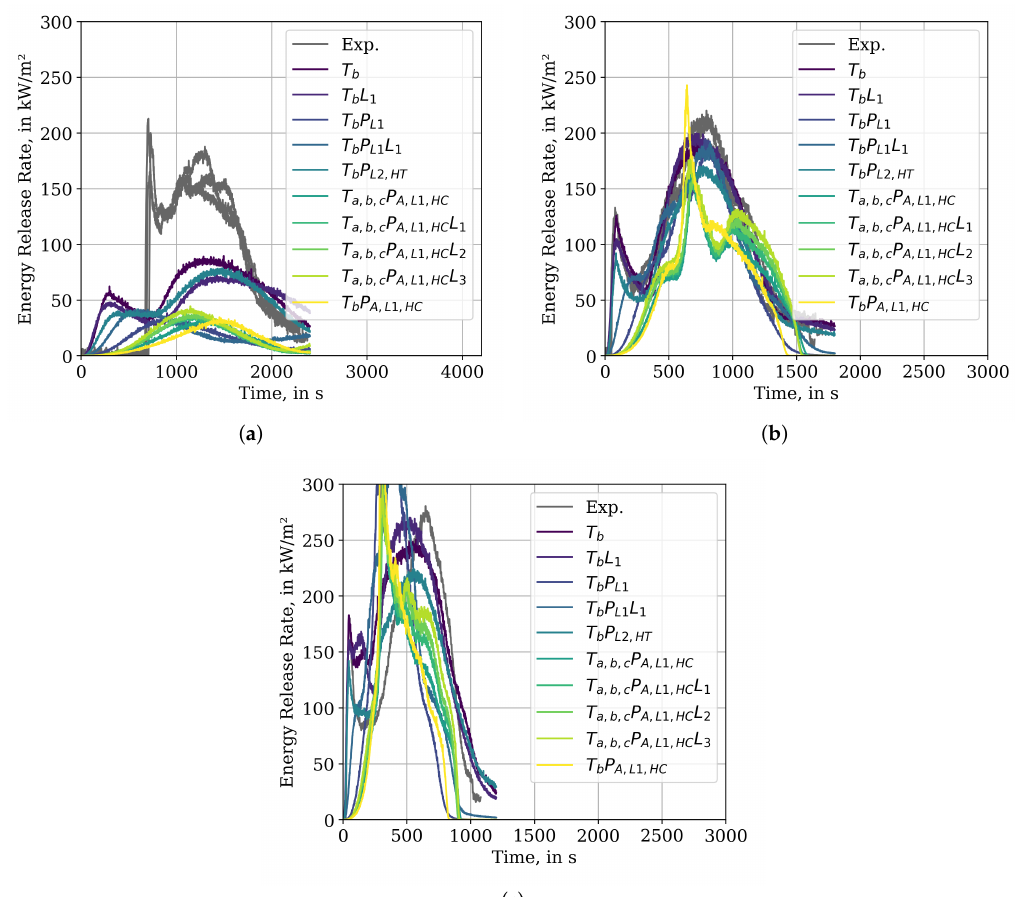
Figure A4. Energy release rates of the best parameter set for IMPs with adjusted parameter limits (SCC). ( a ) Incident heat flux of 25 kW / m 2 . ( b ) Incident heat flux of 50 kW / m 2 . ( c ) Incident heat flux of 75 kW / m 2 .